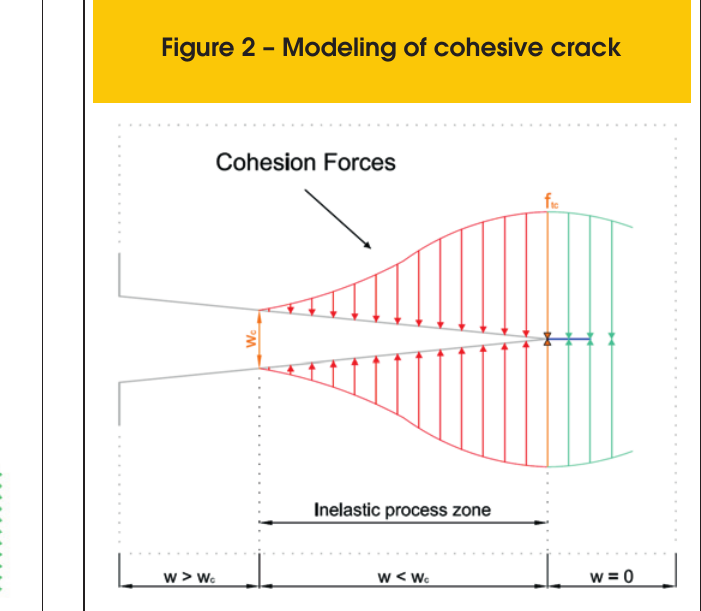
Figure 2 – Modeling of cohesive